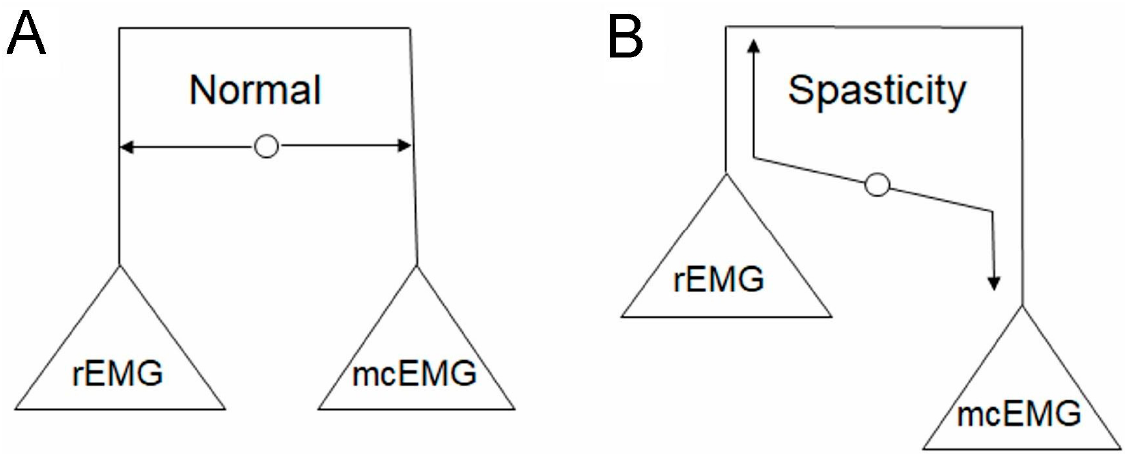
Figure 5. Illustration of the relationship between the amplitude parameters of electromyography recordings at rest (rEMG) and during attempts of maximal muscle contraction (mcEMG) in a healthy subject ( A ) and a post-stroke patient before therapy ( B ). Note the abnormal increase if the muscle tension at rest leads to a decrease in muscle motor unit activity during voluntary movement.